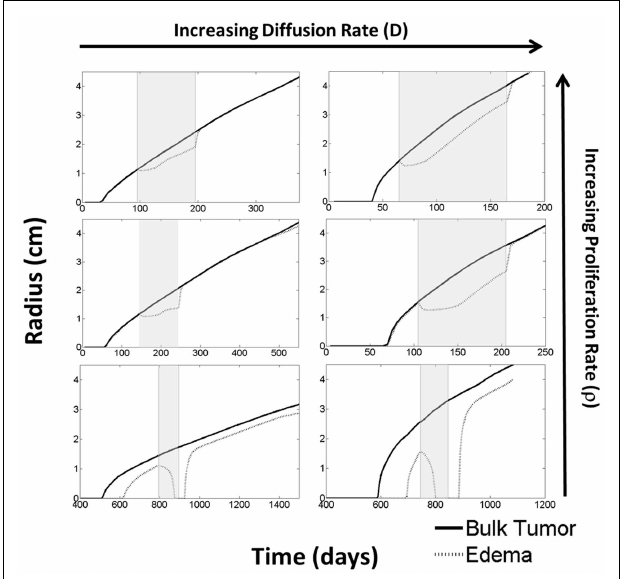
FIGURE 6 | Using the PIHNA-E model, holding all parameters constant except for D and ρ , one can observe many different responses to anti-angiogenic treatment in terms of the levels of edema. These responses vary from complete disappearance of imageable edema to stabilized lower levels to lowered levels of edema that continue to increase. When treatment is terminated, however, edema levels are always seen rise to once again reflect more closely the underlying disease burden. Treatment times are indicated by the gray boxes.These simulations suggest that the majority of imaging responses can be explained by considering how the drug impacts the tumor microenvironment alone without cytotoxic affects. Additionally, they represent a possible mechanism for identifying the patients who will receive significant benefit from the